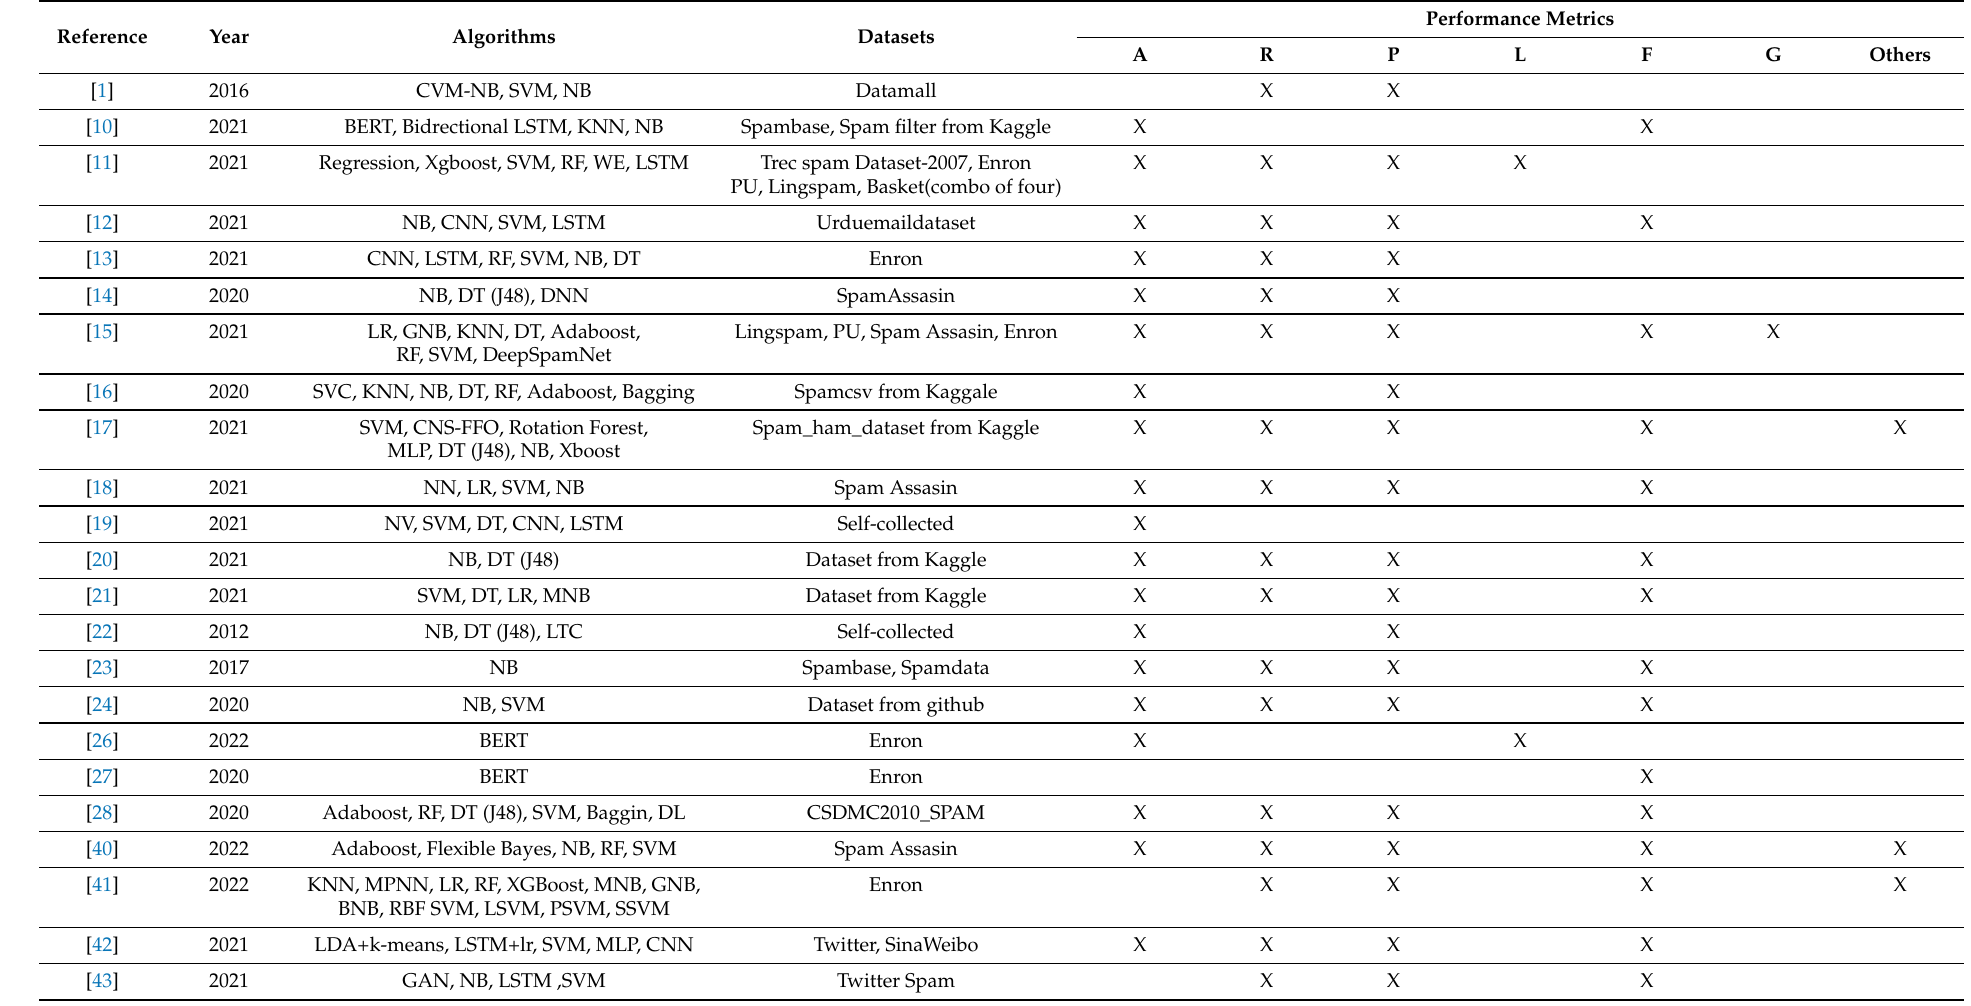
Table 2. Summary of studies on email spam detection. A—accuracy; R—recall author; P—precision; L—loss, F—f-score/F1 score;